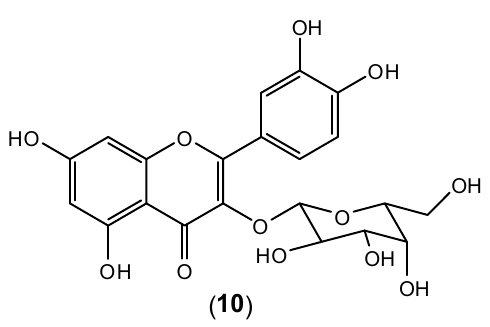
Figure 9. Structure of hyperoside ( 10 ).